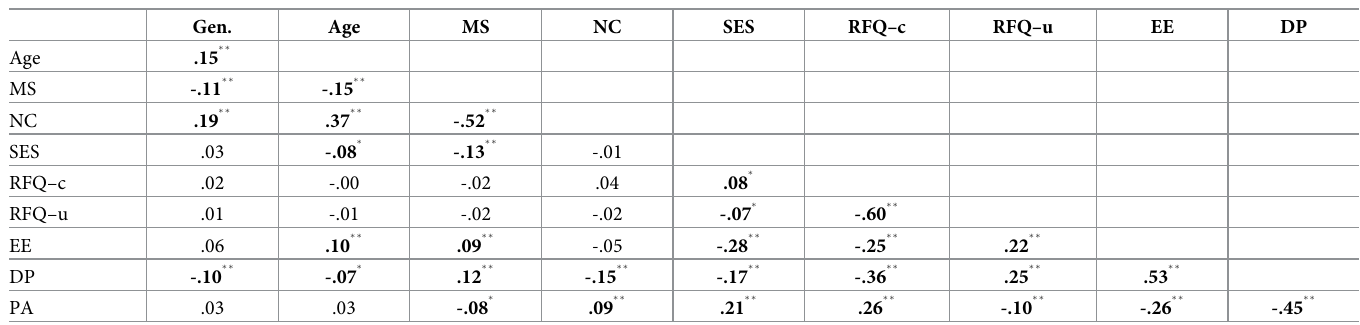
Table 2. Correlations between variables.